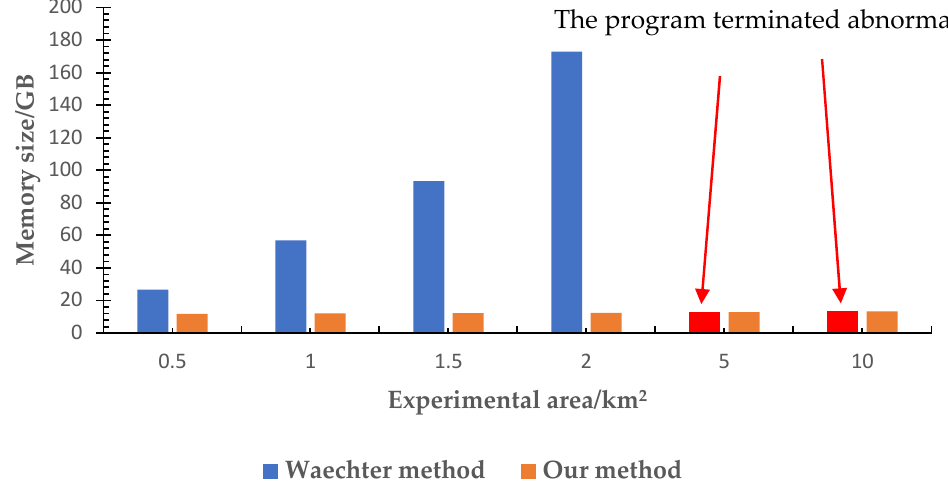
Figure 12. Bar graph for the memory consumption comparison.